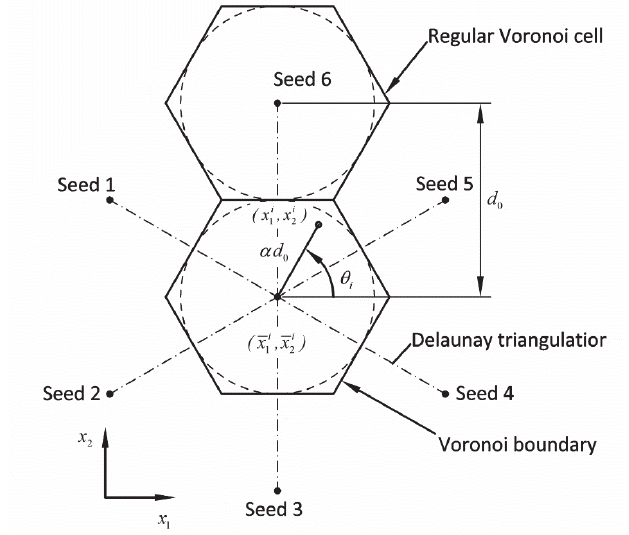
Figure 4: Geometric perturbation of the coordinates of regular array of seeds.